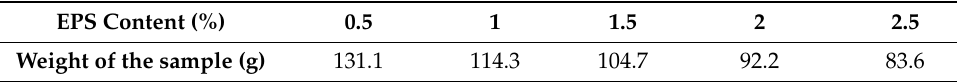
Table 5. Weight of the